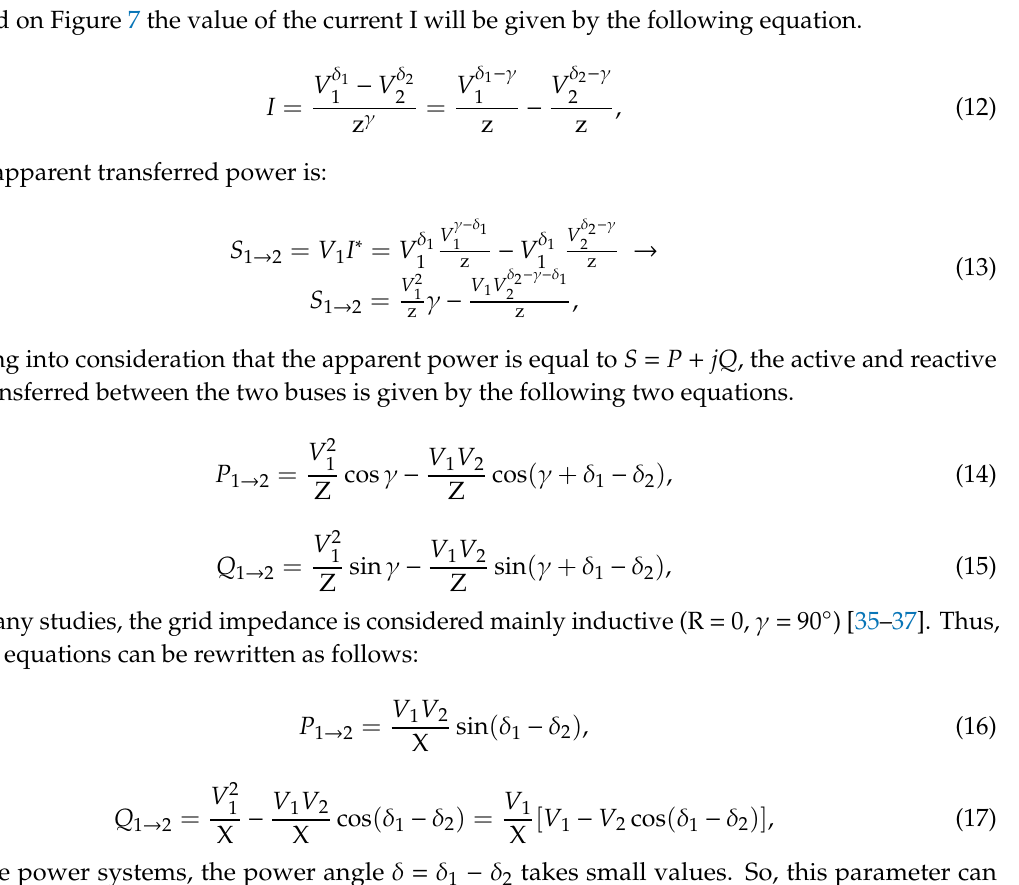
Figure 7. Two AC buses connected through the transmission line.